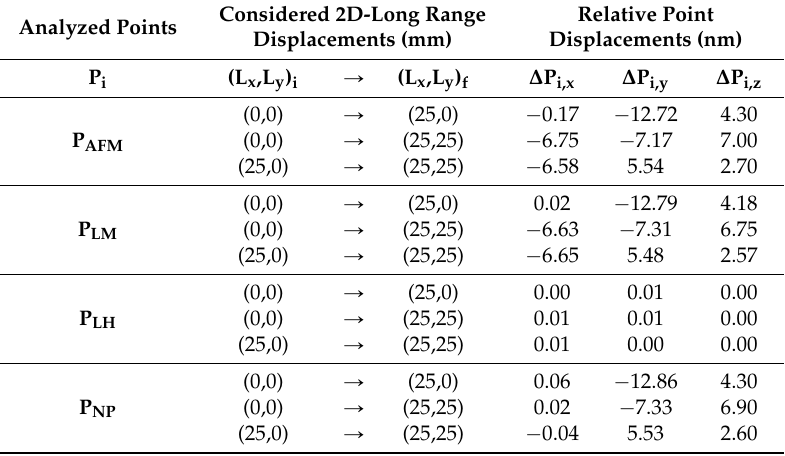
Table 1. Relative displacements of the interesting points (detailed